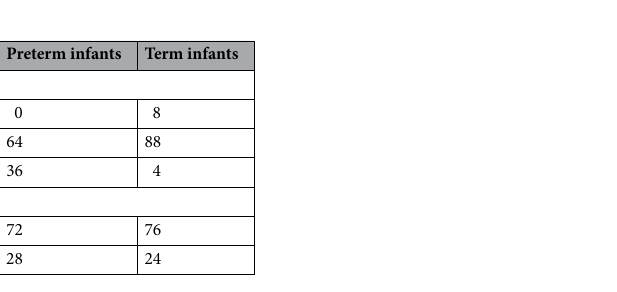
Table 4. Symmetrical and asymmetrical head shape deformities in preterm and term